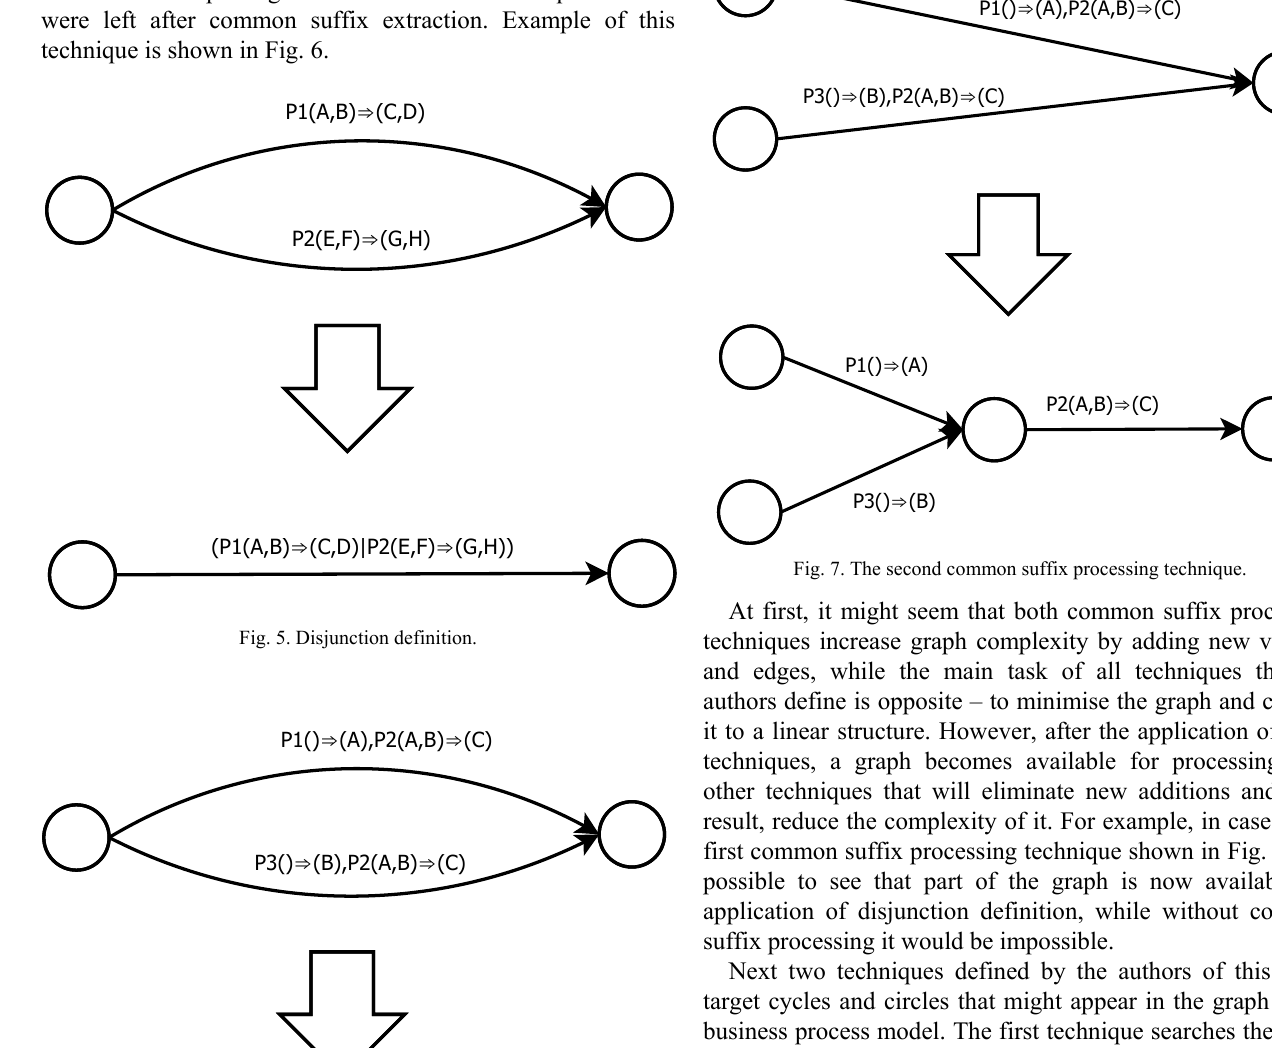
Fig. 5. Disjunction definition.